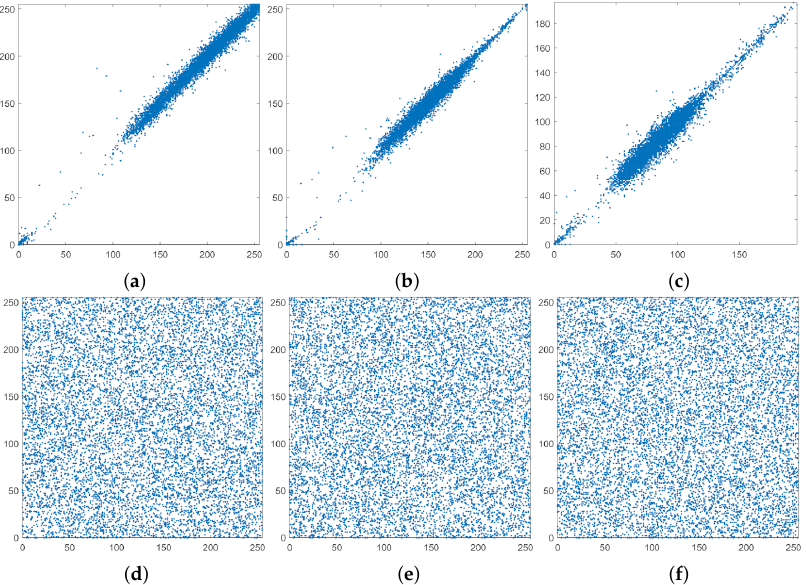
Figure 17. Correlation distributions of image number 15 (sick patient). ( a ) Original image, red channel. ( b ) Original image, green channel. ( c ) Original image, blue channel. ( d ) Encrypted image, red channel. ( e ) Encrypted image, green channel. ( f ) Encrypted image, blue